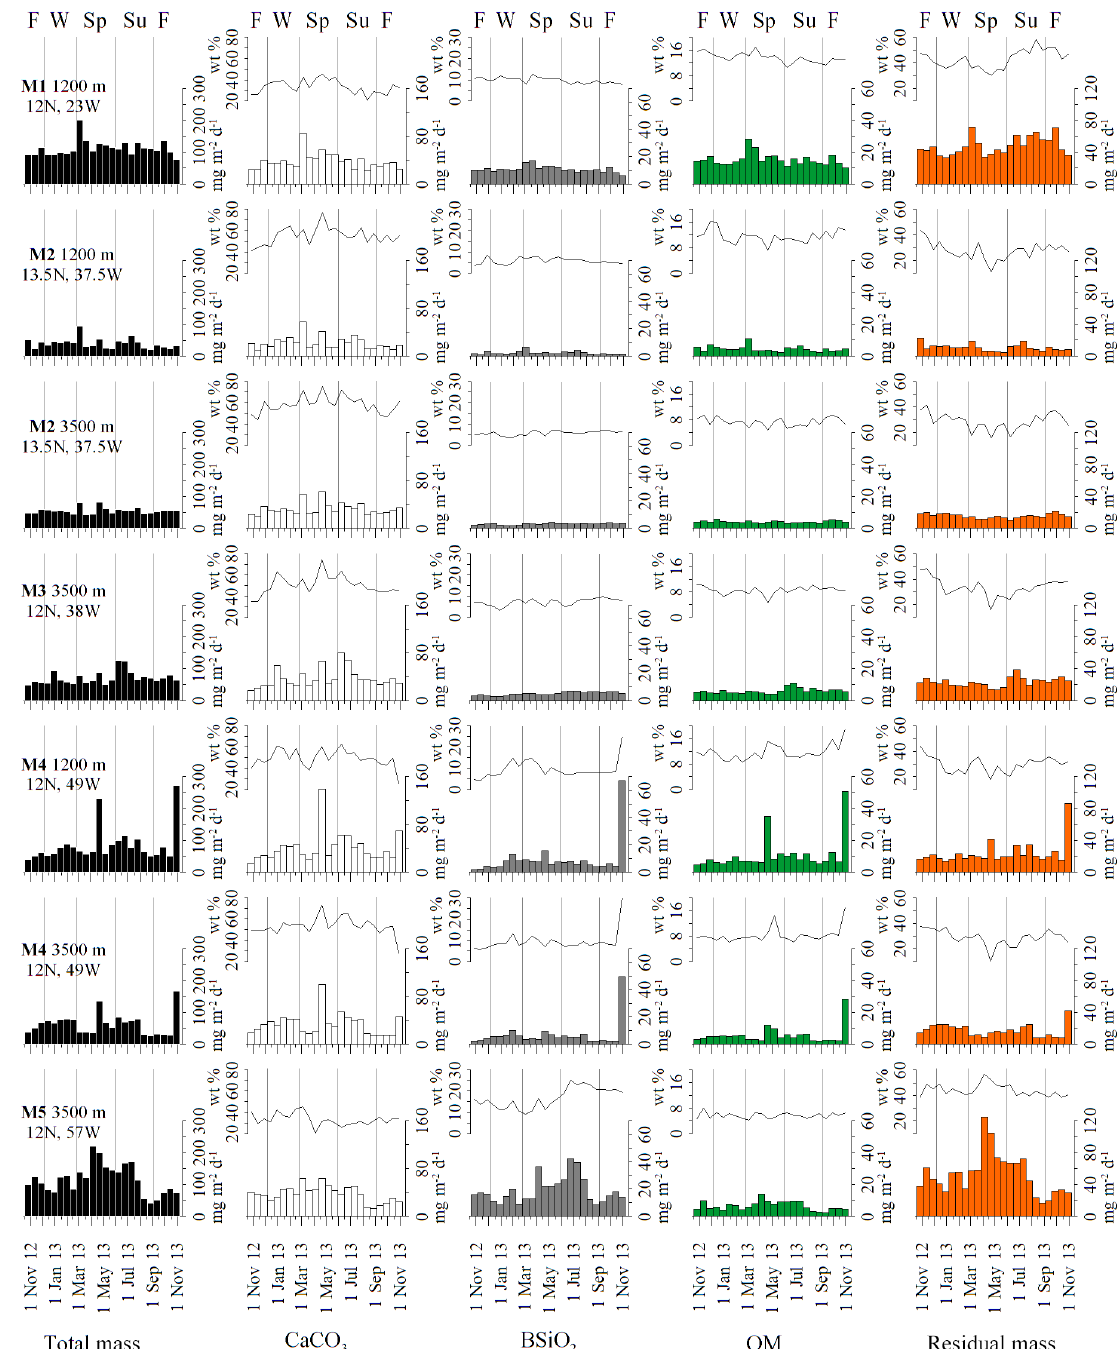
Figure 3. Mass fluxes at ocean site M1U to M5L (mgm − 2 d − 1 , bars) for total mass (black), CaCO 3 (white), BSiO 2 (grey), organic matter (green) and the residual mass fraction (orange); black lines represent their relative contributions (wt%). F = Fall, W = Winter, Sp = Spring and Su =